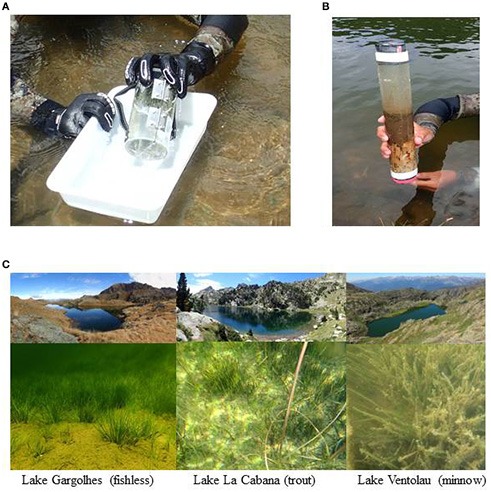
Cylindrical section dredge used to collect quillwort leaves (A) and a core of sediment from Tres Estanys (B; minnow lake) were different phases of the water-sediment interphase can be distinguished. Lake scenarios under examination (C) with an underwater view of the quillwort meadows.